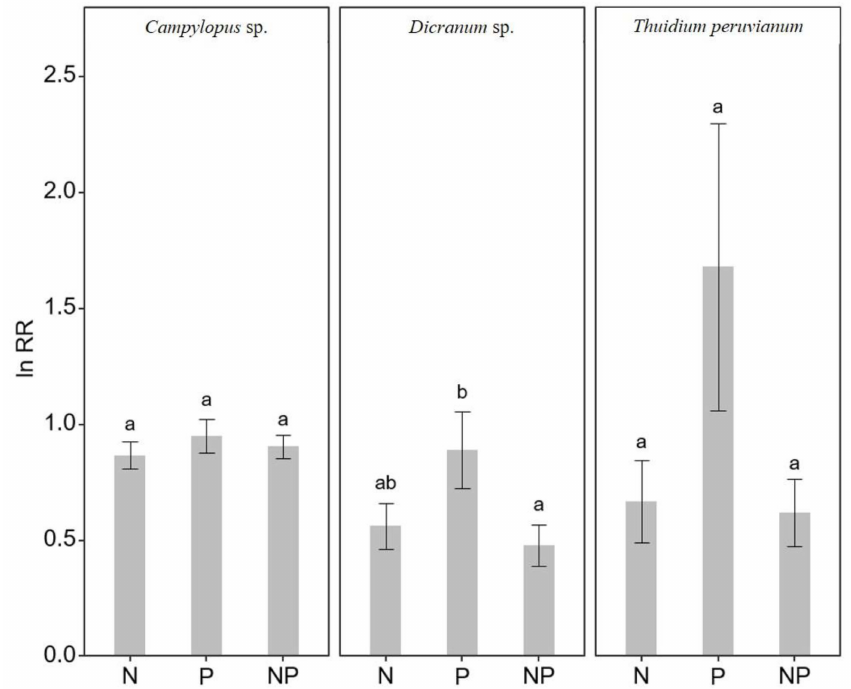
Figure 5. Mean response ratio (ln (natural logarithm) RR, n = 24, ± SE, across all time points) of nitrogenase activity across the treatments (nitrogen (N), nitrogen and phosphorus (NP) and phosphorus (P)) relative to the control treatment, in three moss species ( Campylopus sp., Dicranum sp. and Thuidium peruvianum ) collected in a tropical mountain cloud forest in Peru. Different letters (a/b/ab) show statistically significant (Tukey HSD test) differences between